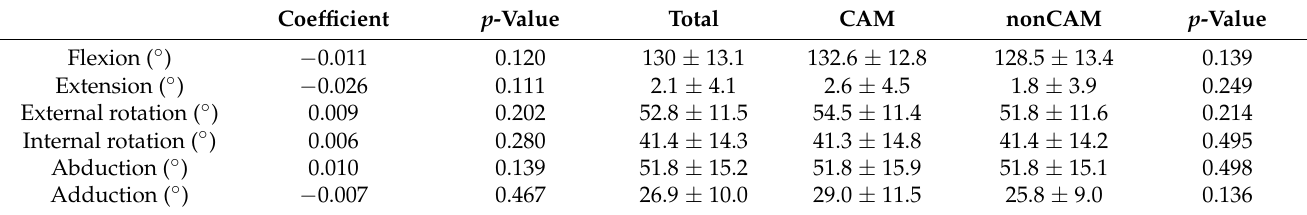
Table 2. Hip range of motion in the CAM and nonCAM